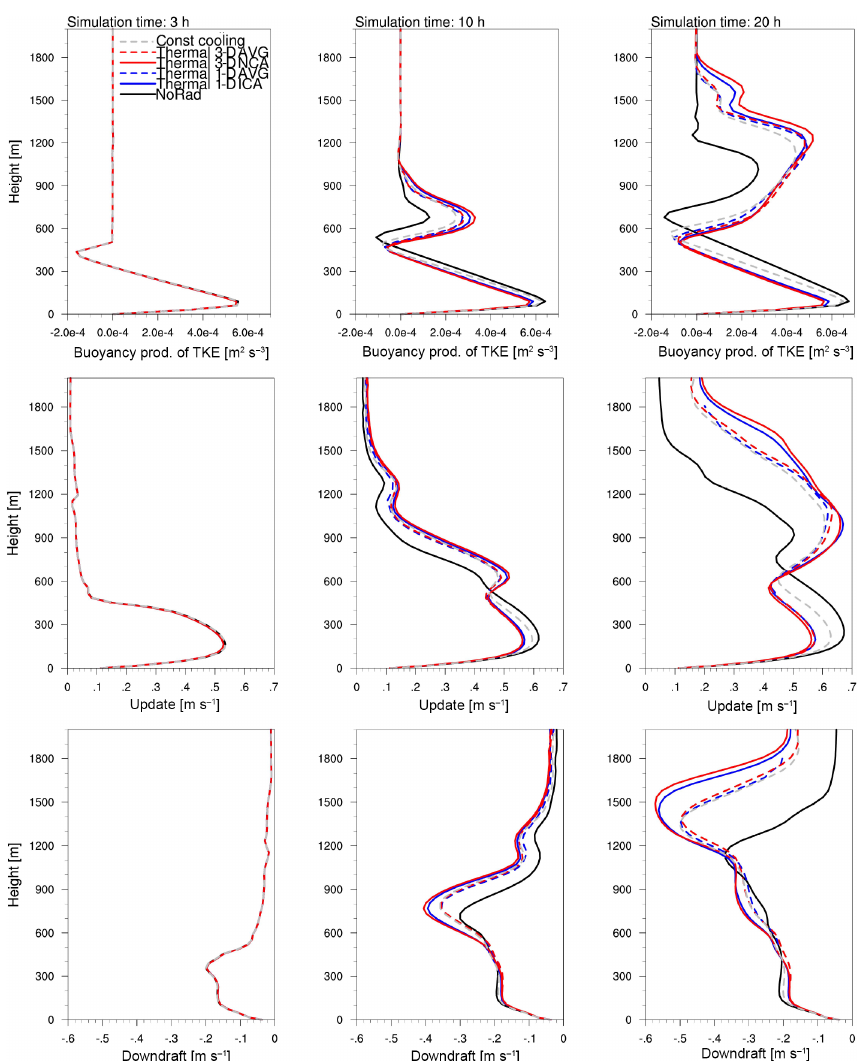
Figure 11. Time-averaged profiles of buoyancy production of the turbulent kinetic energy (TKE) and updraft and downdraft vertical veloc- ity.The profiles are shown at the restart time (3h) as a 3h average centered at 10 and 20h of the simulations. Updraft and downdraft vertical velocities were extracted from the 3-D data following Park et al.